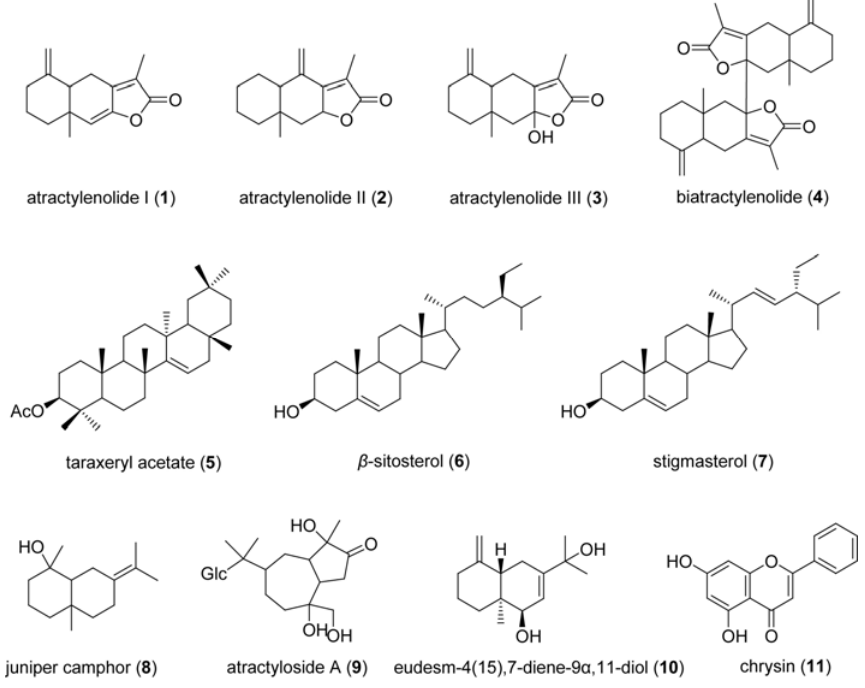
Figure 2. Chemical structures of compounds 1 - 11 .